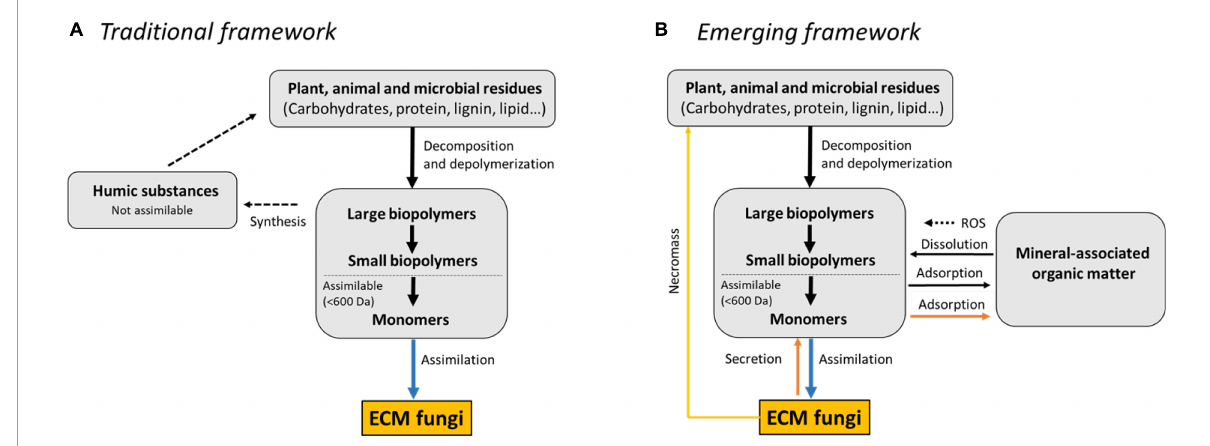
FIGURE2 The traditional and emerging frameworks for organic nitrogen acquisition in ectomycorrhizal (ECM) fungi. (A) The traditional framework. In this framework, organic N molecules, including proteins, are considered to be embedded in soil organic matter (SOM) and are stabilized by selective preservation of recalcitrant plant biopolymers coupled with abiotic synthesis of complex, highly aromatic humic substances resistant to microbial decay (black, dotted arrow). SOM is decomposed by ECM fungi (black arrow) through the activity of extracellular enzymes to small, water-soluble molecules such as amino acids and peptides that can be assimilated by the fungi (blue arrow). (B) Emerging framework. In this framework, SOM is viewed as a range of organic fragments and microbial products that are continuously processed into smaller molecules by decomposing microorganisms. SOM is decomposed by ECM fungi (black arrow) through the activity of extracellular enzymes and oxygen radicals generated by Fenton chemistry to small, water-soluble molecules that can be assimilated by the fungi (blue arrow). Concomitantly, SOM is modified into a material with enhanced affinity to mineral particles. Moreover, SOM decomposition is accompanied with a substantial secretion of low-molecular-weight compounds (brown arrow). Some of them have Fe(III) reducing activity and can participate in the dissolution of iron oxide mineral particles and generation of reactive oxygen species (ROS) by Fenton-like mechanisms. Others bind strongly to mineral surfaces and can facilitate the hydrolysis of mineral-associated organic N sources (i.e., proteins) by conditioning the mineral surface in a way that protects direct sorption and subsequent deactivation of fungal proteases. ECM fungal biomass, in turn, also contributes substantially to the formation of SOM through necromass that is left behind after cell